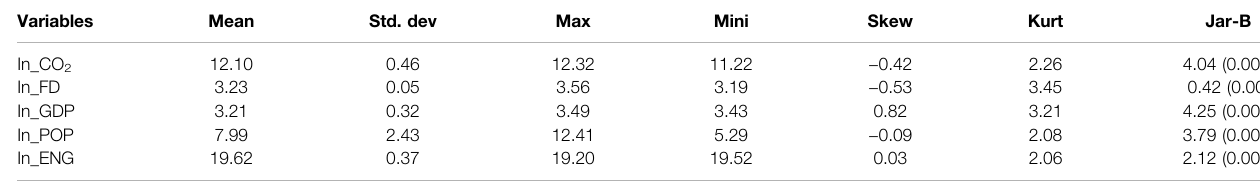
TABLE 1 | Stationarity of factors in summary statistics. Variables